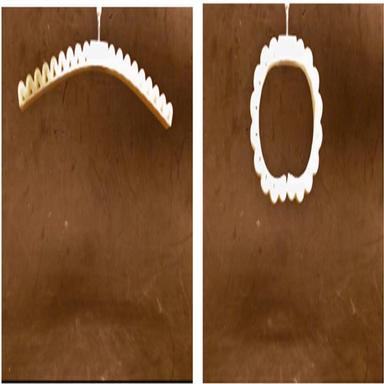
Bending-close behavior under a pressure of 24 psi.